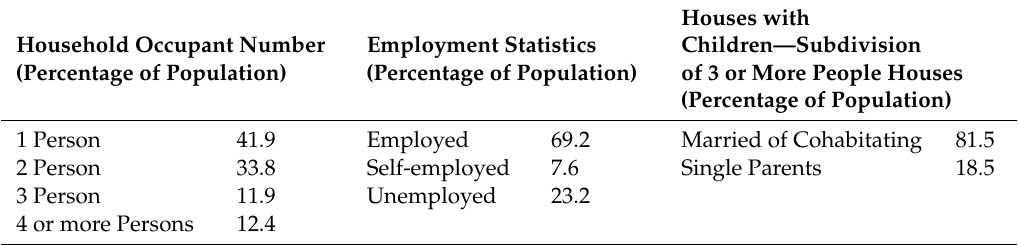
Table 1. Population demographics Germany